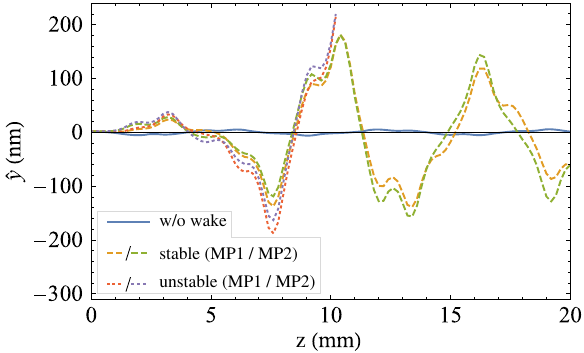
FIG. 10. Bunch distribution divided in two halves (MP1 and MP2) and tracked through a dual pillar APF grating with a 0 . 8 μ m period length. The betatron motion without wake is shown for comparison